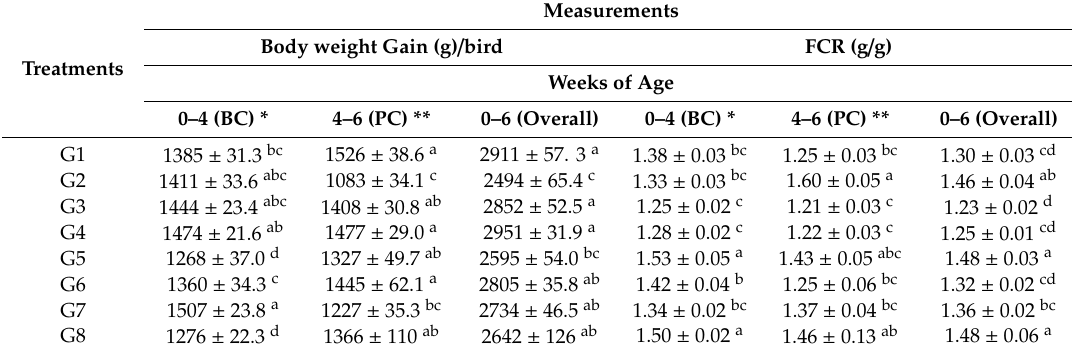
Table 2. Growth performance ( ± SD) for experimental groups before and post SE experimental challenge.